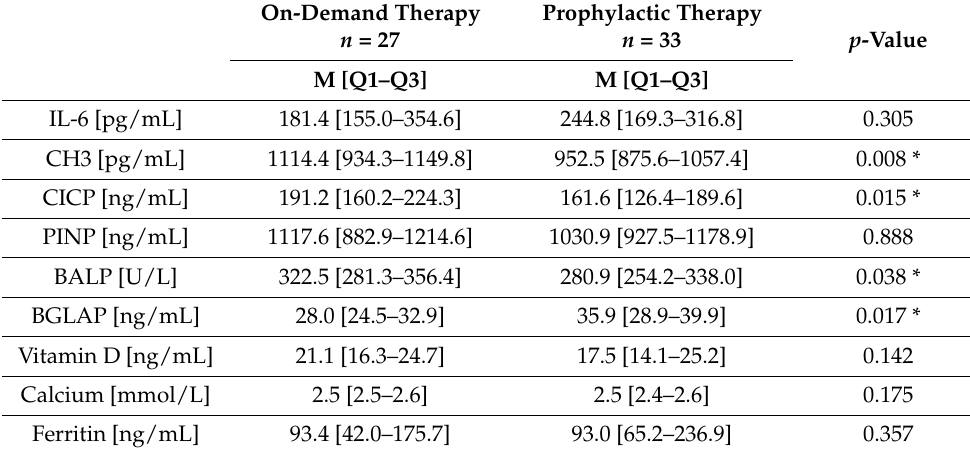
Table 3. Comparison of concentrations of interleukin 6 (IL-6); citrullinated histone CH3 (marker of neutrophil extracellular trap); markers of bone formation (osteocalcin (BGLAP), bone alkaline phosphatase (BALP), N-terminal propeptide of type I procollagen (P1NP)); bone resorption marker C-terminal telopeptide of type I collagen (C1CP); and vitamin D, ferritin and serum calcium, depend- ing on the haemorrhagic prophylaxis used (on-demand/prophylactic therapy) (median and Q1–Q3). On-Demand Therapy